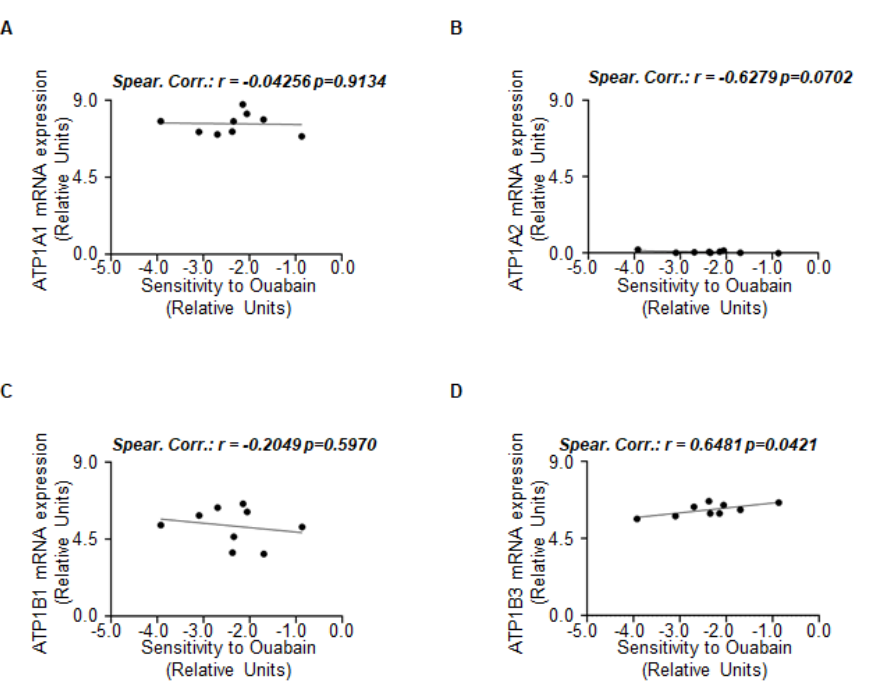
Figure 5. The correlation between Na/K ATPase isoforms and sensitivity to ouabain in breast cancer cell lines. Plots have been generated by using the data in the DepMap portal. Each dot of the plots refers to the value of the specific parameter in a single ER α -positive breast cancer cell line. For details, please see Supplementary Table S5. ( A – D ) Linear regression between sensitivity to ouabain (OU) and the mRNA expression of the indicated genes.